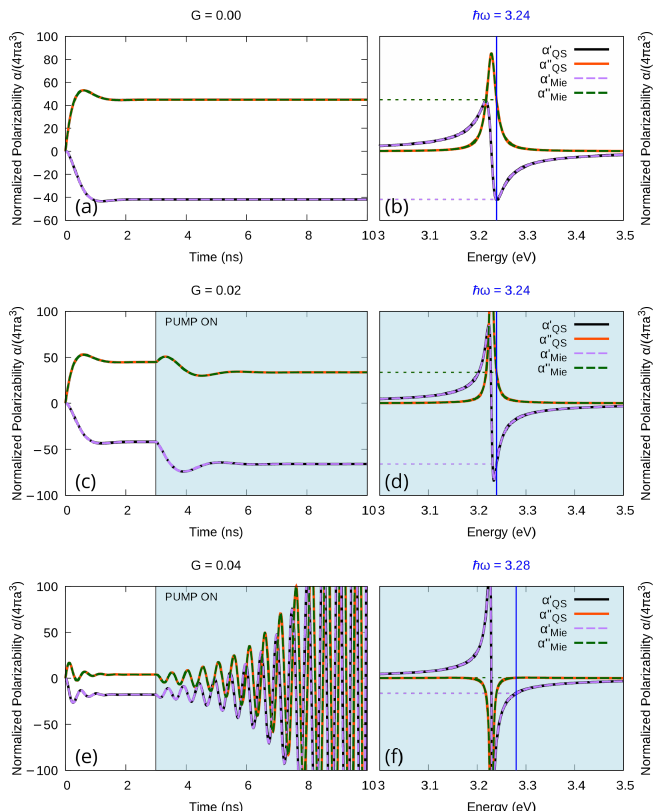
Figure 1. Real and imaginary part of the Polarizability of a silver nanoparticle of radius 1 nm in water enriched with a gain medium with emission central frequency ¯ h ω 21 = 3.23 eV and emission width ∆ = 0.15 eV. ( a , b ): No gain is added to the system. ( c , d ): Some gain is included, but the system remains sub-emissive ( G = 0.5 · G th ). ( e , f ): Enough gain is included to drive the system to the emissive regime ( G = 1.1 · G th ). ( a , c , e ): Time dependence of the polarizability for a single frequency; ( b , d , f ): corresponding steady state spectrum.